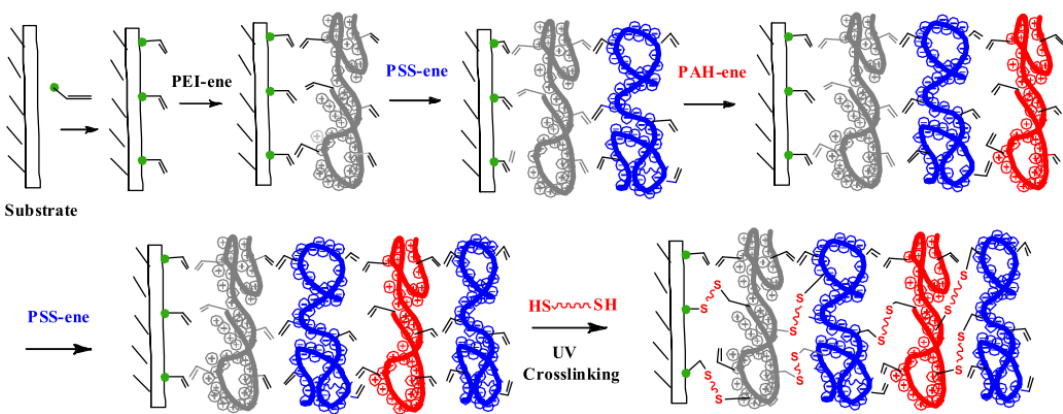
Figure 1. A strategy towards improving stability of polyelectrolyte complex (PEC) films on substrates by cross-linking. Republished with permission of the Royal Society of Chemistry, from [9].